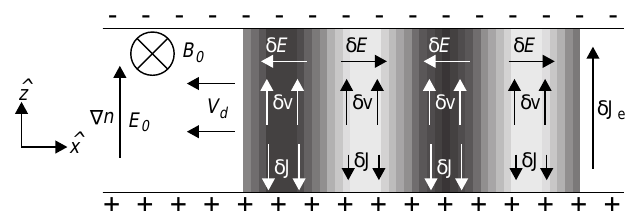
Fig. 1. Schematic representation of wave-driven currents in the equatorial electrojet. On the left of the figure, we show the vertical electrojet electric field, E 0 , the geomagnetic field, B 0 , the plasma- density gradient, ~r n , and the electrojet electron drift direction, V d . If V d exceeds a threshold then compressional plasma waves develop as shown by the varying shades of grey, darkest where the waves enhance the plasma density and lightest where they reduce it. At the density maxima and minima, we show the direction of the perturbed electric field, (cid:100) E , the direction in which the electrons drift in response to (cid:100) E ; (cid:100) v , and the resulting electron current, (cid:100) J (cid:100) v . This current is larger (cid:136) n where the plasma density is enhanced than were it is reduced. On the right, we show the direction of the net, wave-driven, vertical electron current, (cid:100) J e . An identical mechanism generates wave-driven currents in the auroral electrojet when ~ r n (cid:136) 0 ; E 0 is horizontal, and B 0